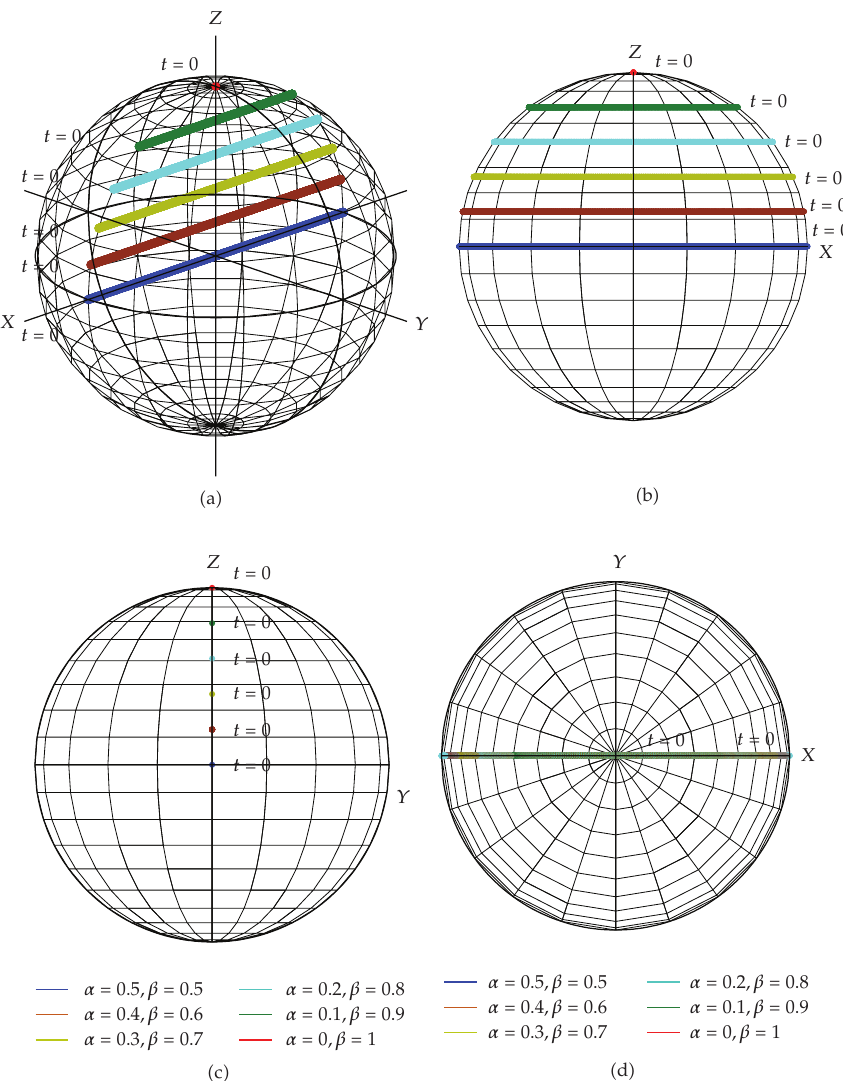
Figure 9: Excess electron spin dynamics on the bloch sphere for large Δ